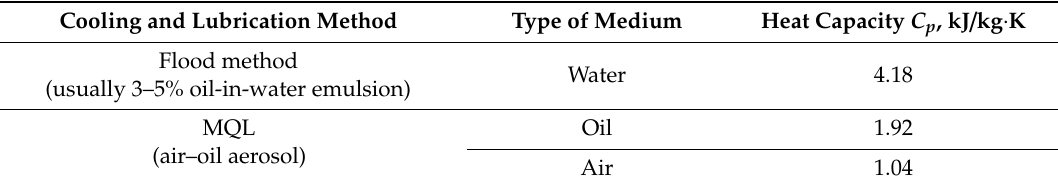
Table 1. Heat capacity values for water, oil, and air